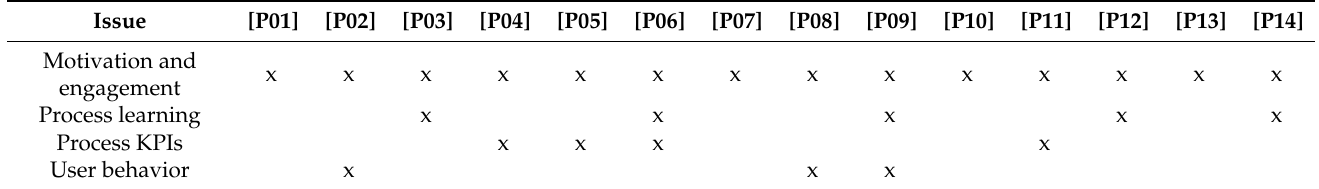
Table 10. Issues addressed by gamification in the primary studies. KPI: key performance indicators.